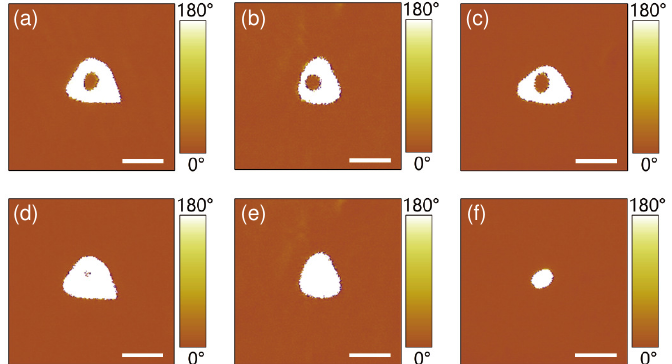
Figure 4. ( a – c ) The PFM images of donut-shaped domains fabricated with the same step-1 poling field of U DC 1 = 40 V and t p 1 = 1 s. ( d – f ) The corresponding PFM images of domain structures after the step-2 poling with different field magnitude U DC 2 = − 51 V, − 52 V and − 100 V, respectively. The pulse duration of the step-2 poling field was set to be t p 2 = 1 ms. Scale bar: 100 nm.